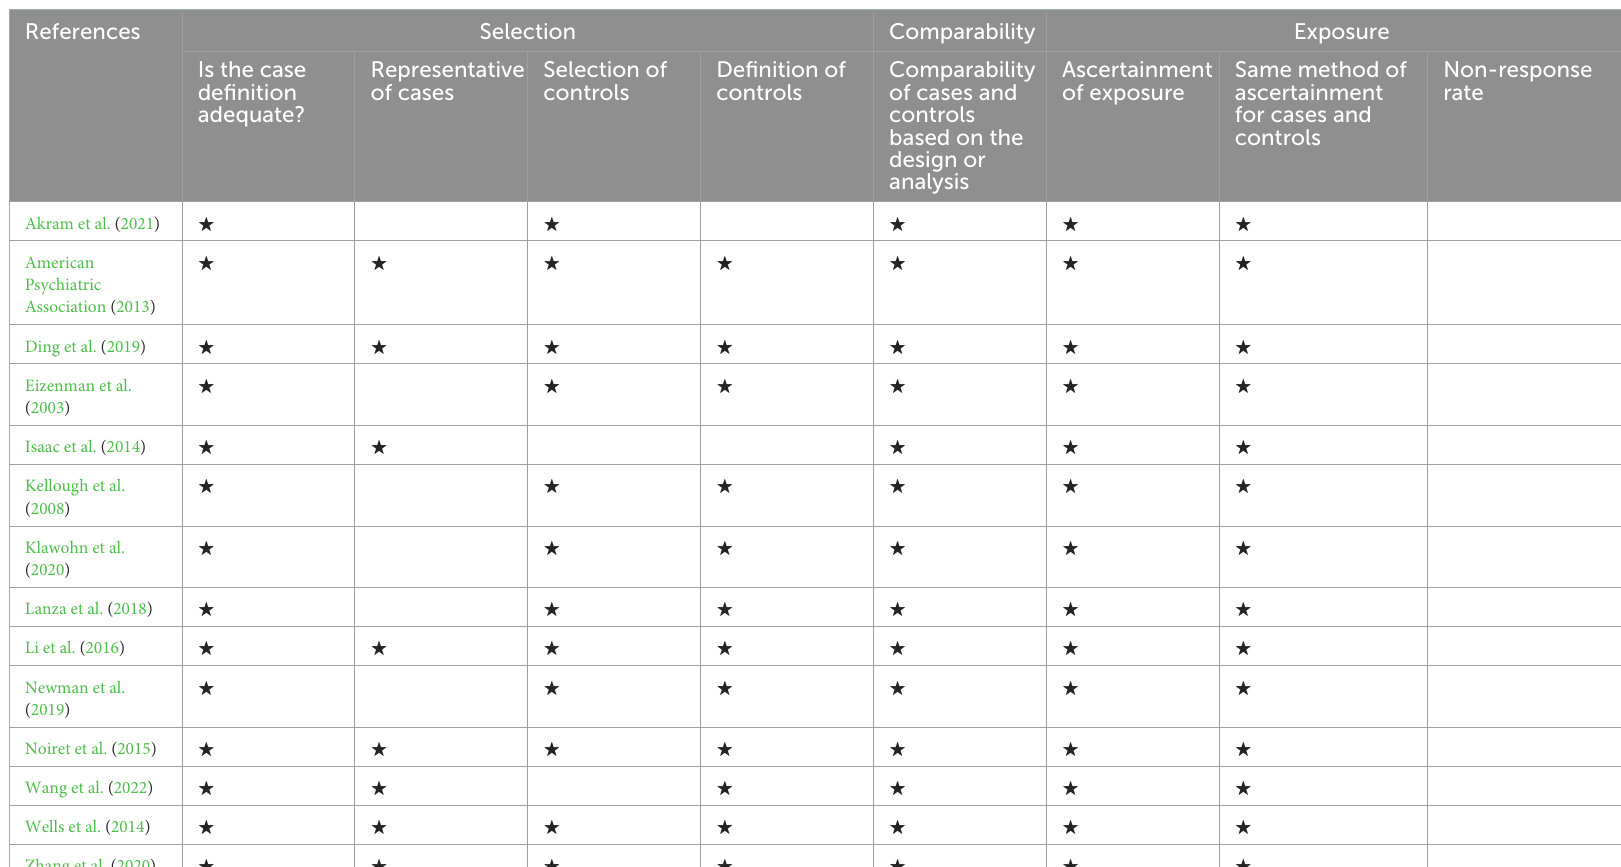
TABLE 2 Quality of individual